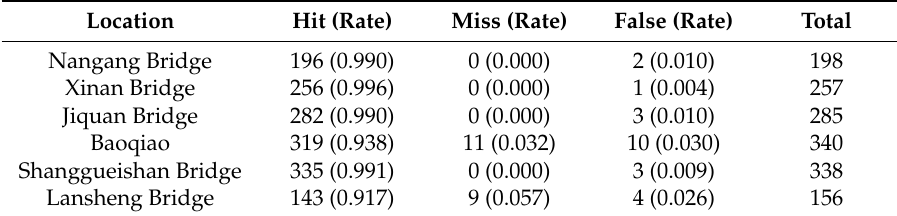
Table 3. The hit, miss, and false alarm statistical measures from six stations sending notifications via e-mail. Hit means the assessment fit the actual situation. Miss means a false negative situation. False means a false positive